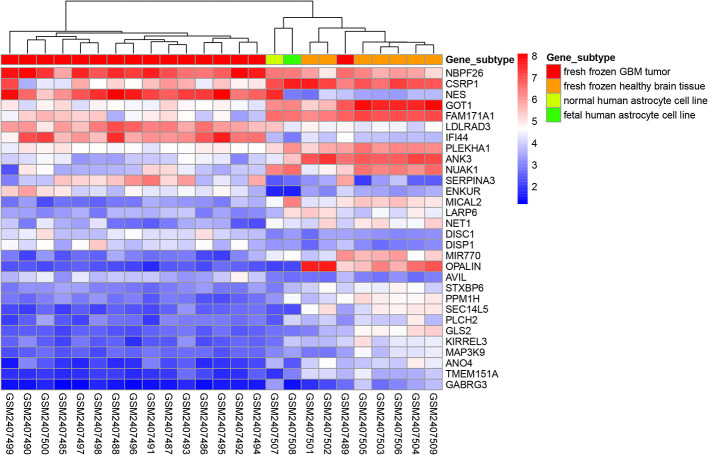
Heatmap of cluster analysis of DEGs expression in the GSE90598 dataset. The heatmap represents the differential expression profiles of DEGs (top 30) in GSE90598 microarray, all the 25 samples are hierarchically clustered. The molecular subtype of each sample was labeled: fresh frozen GBM tissue; fresh frozen healthy brain tissue; normal human astrocyte cell line; fetal human astrocyte cell line.